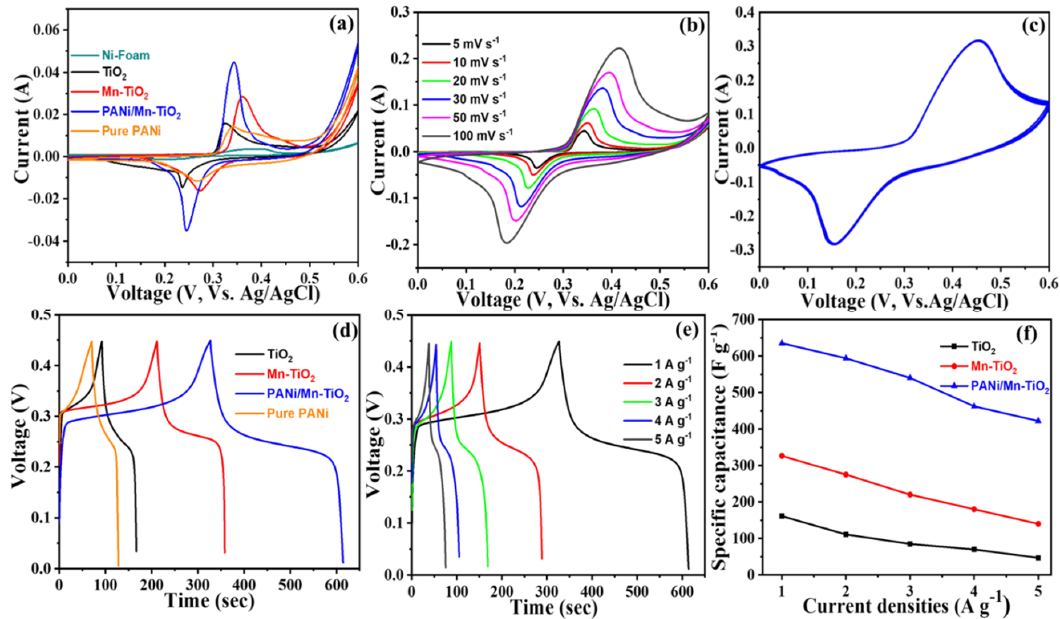
Figure 4. Electrochemical measurements in three electrode cell setup in 2 M KOH, ( a ) CV curves of TiO 2 , Mn-TiO 2 , PANi/Mn-TiO 2 , and Pure PANi at 5 mV s −1 ; ( b ) CV curves of PANi/Mn-TiO 2 at various scan rates; ( c ) 30 consecutive cycles of PANi/Mn-TiO 2 at 150 mV s −1 ; ( d ) GCD profile of TiO 2 , Mn-TiO 2 , PANi/Mn-TiO 2 , and Pure PANi at current density of 1 A g −1 ; ( e ) GCD curves of PANi/Mn-TiO 2 at different current densities; ( f ) specific capacitance of TiO 2 , Mn-TiO 2 and PANi/Mn-TiO 2 at different current densities.